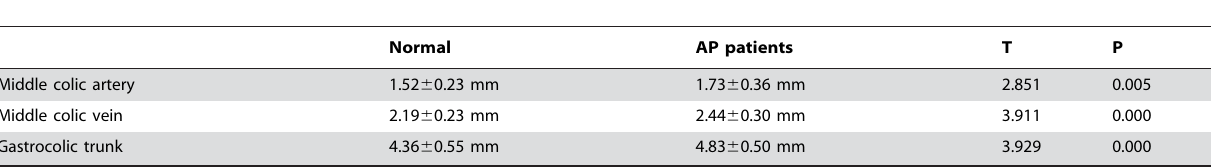
Table 1. The blood vessels of the transverse mesocolon in normal patients and patients with AP.